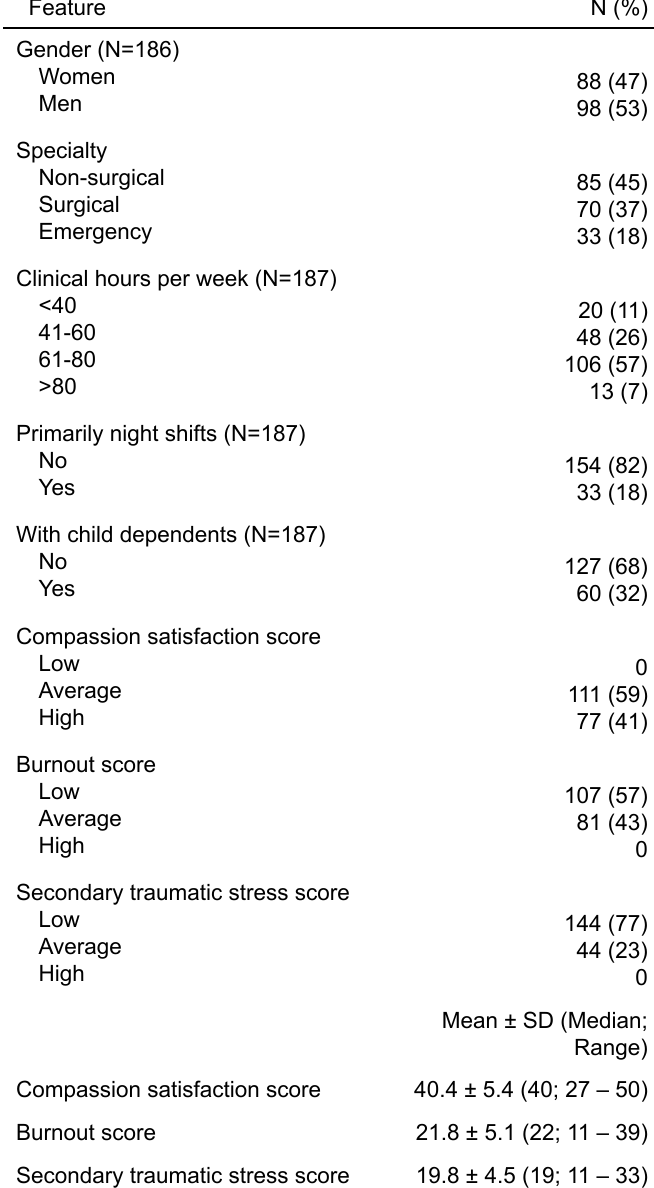
Table 1 . Summary of features for 188 resident respondents and measures of the subscales of compassion